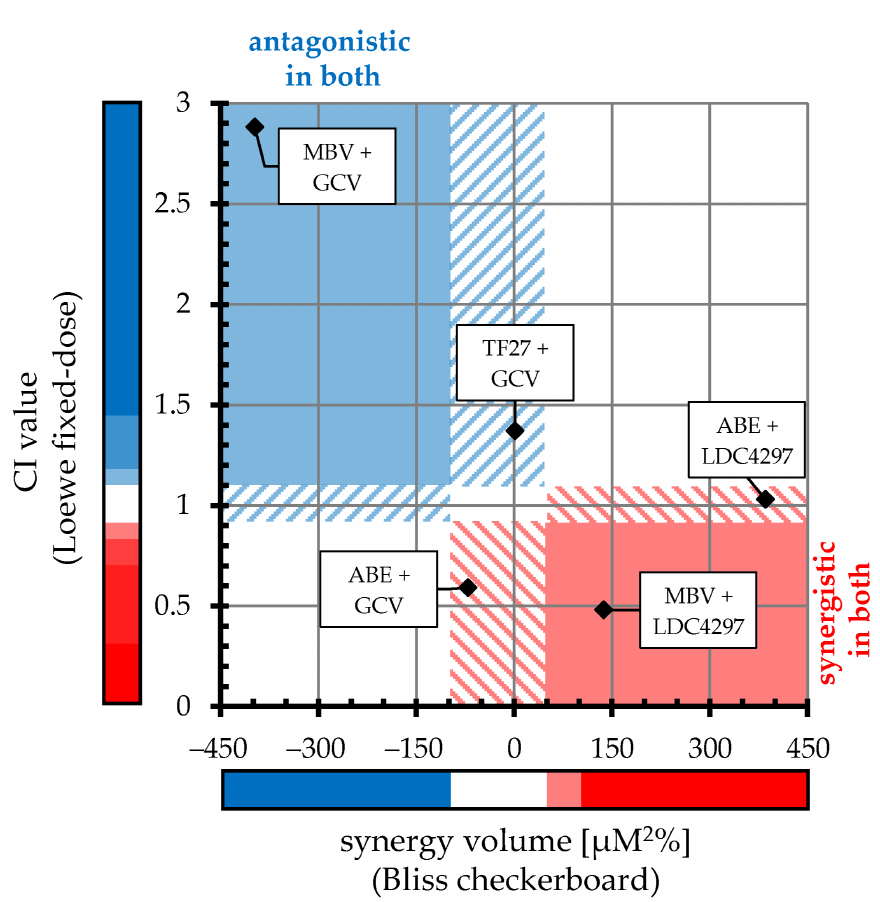
Figure 7. Comparative alignment of HCMV-specific Loewe fixed-dose and Bliss checkerboard re- sults. X-axis value of each drug combination indicates mean synergy volume across checkerboard assays (positive and negative synergy volumes were added together to acquire one plottable value). Y-axis value indicates mean CI wt across fixed-dose assays. Colored bars represent ranges of an- tagonistic (blue), additive (white) and synergistic (red) interactions for each approach (specified in Tables 2 and 3). Solid blue/red fields within the chart indicate overlapping antagonistic/synergistic range of both approaches, respectively; dashed blue/red areas designate antagonistic or synergistic ranges in one method with additive values in the other